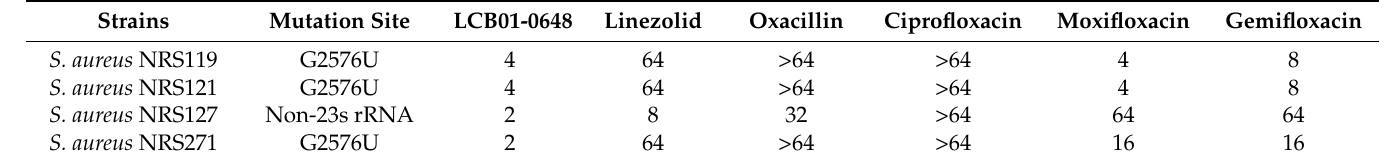
Table 4. MIC of LCB01-0648, linezolid, oxacillin, ciprofloxacin, moxifloxacin and gemifloxacin against linezolid-resistant S. aureus